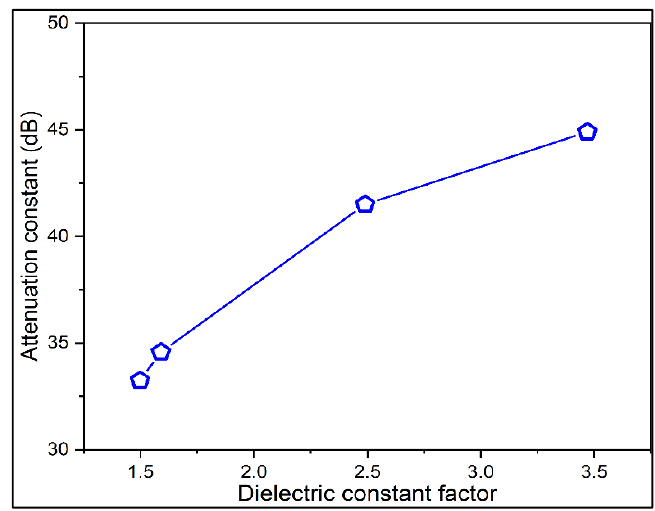
Figure 7. Attenuation versus dielectric constant of wheat flours.